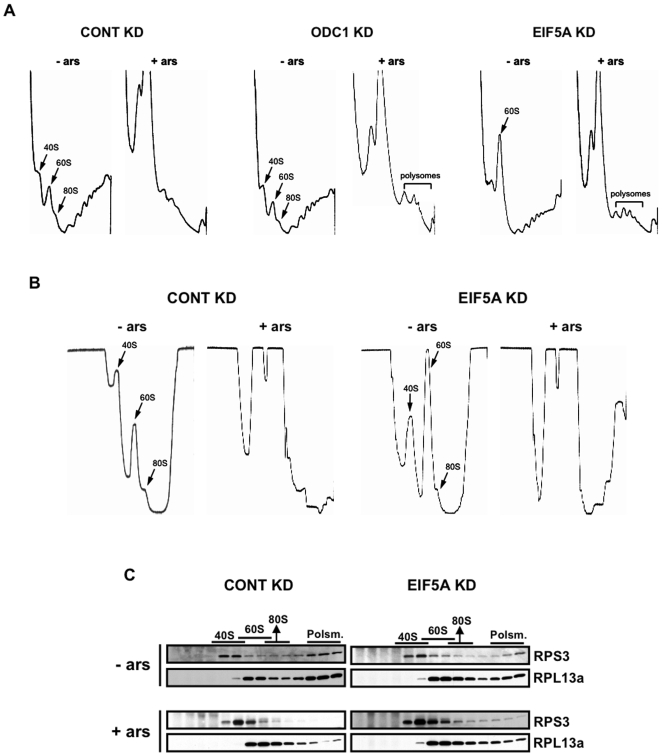
Knockdown of ODC1 or eIF5A inhibits stress-induced polysome disassembly.(A) U2OS cells were transfected with control (CONT KD), ODC1-specific (ODC1KD) or eIF5A-specific (EIF5A KD) siRNAs, then cultured in the absence (−ars) or presence (+ars) of 0.1 mM sodium arsenite before processing for sucrose gradient analysis. The migration of 40S, 60S and 80S ribosomes is indicated by arrows. The migration of preserved low density polysomes is indicated by brackets. (B) The analysis described in (A) was repeated using prolonged centrifugation times and more sensitive readings to improve the resolution of ribosomal subunits. (C) Fractions from control and eIF5A knockdown sucrose gradients were analyzed by Western blotting using antibodies reactive with RPS3 and RPL13a.